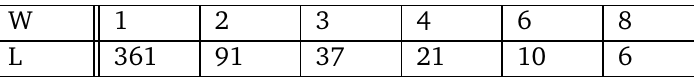
Table 1: Length of initial wave packets L for chosen